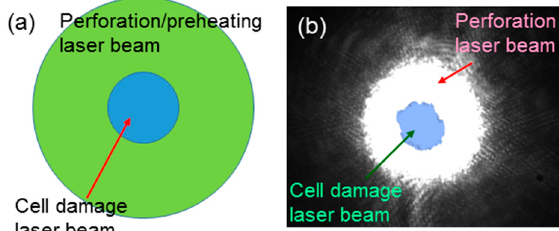
Figure 4. ( a ): Schematic demonstration of the overlap of the cell damage laser beam of a relatively smaller beam size with the perforation or preheating laser beam of a larger beam size. ( b ): CCD images of the defocused beam of the 1064-nm fs laser used for perforation (white region) and the focused beam of the same laser for cell damage (light blue region).